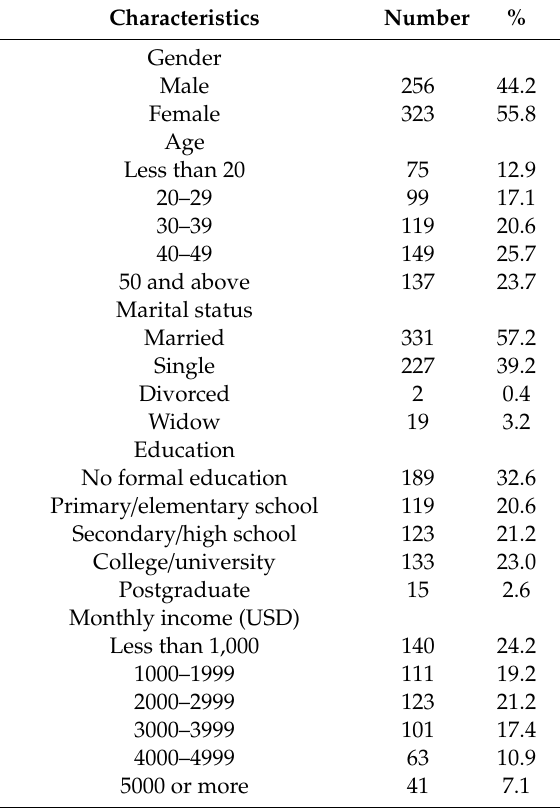
Table 3. Demographic characteristics.